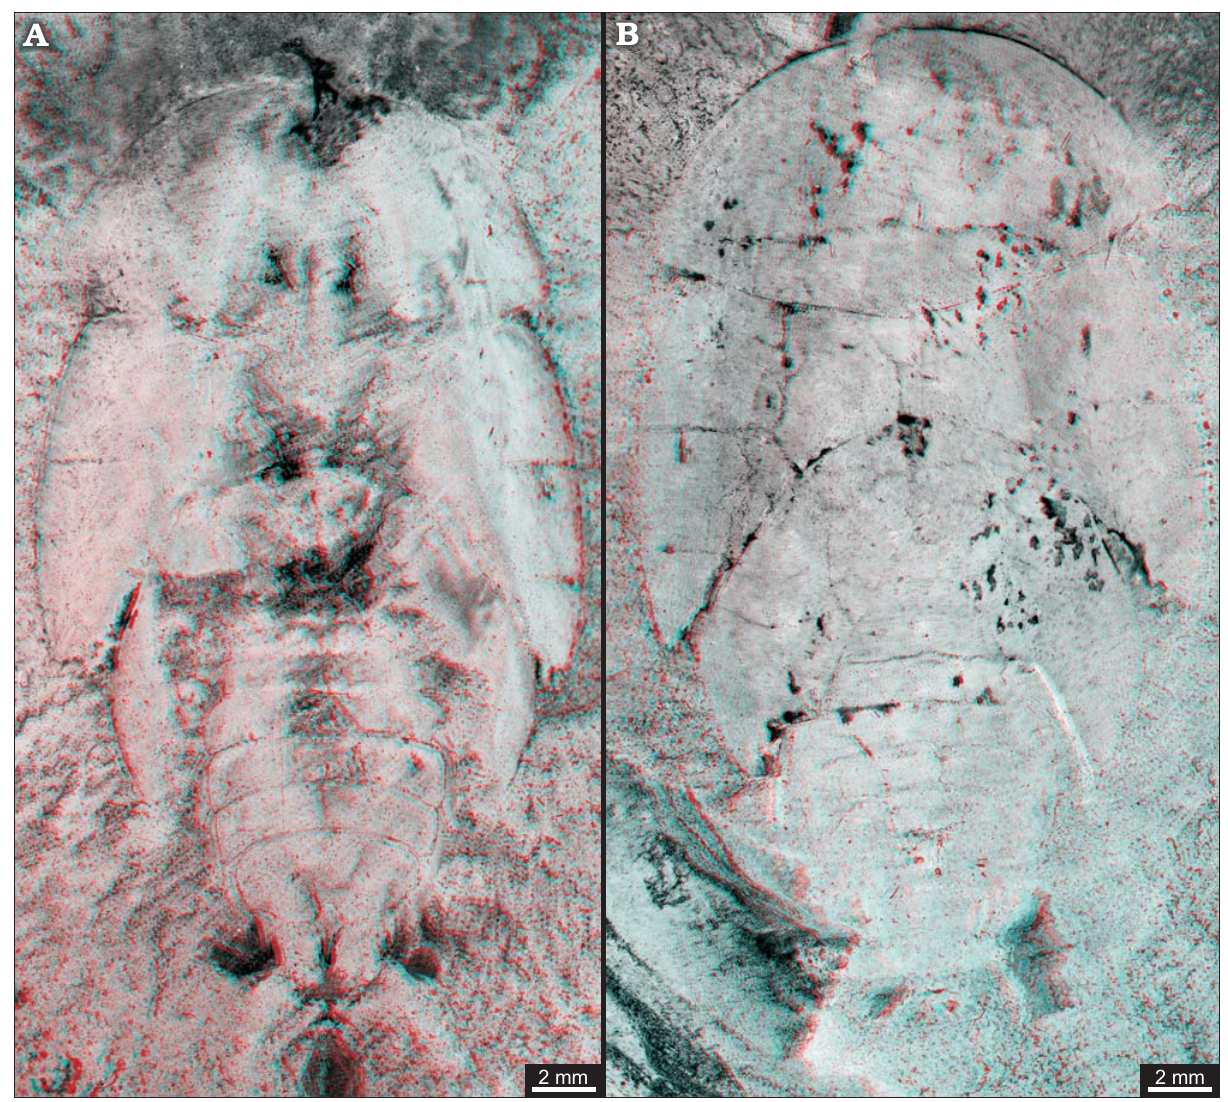
Fig. 7. Roachoid nymph YPM IP 027870 from the Carboniferous Carbondale Formation of Mazon Creek, USA; in dorsal view. Overview of part ( A ) and counterpart ( B ). Red-cyan stereo-anaglyphs (please use red-cyan glasses to